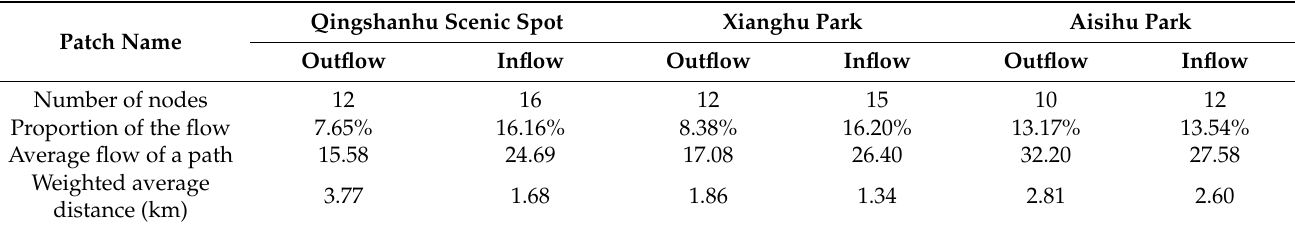
Figure 7. The spatial relationship between first-level patches and nodes. Table 5. Flow characteristics of first-level